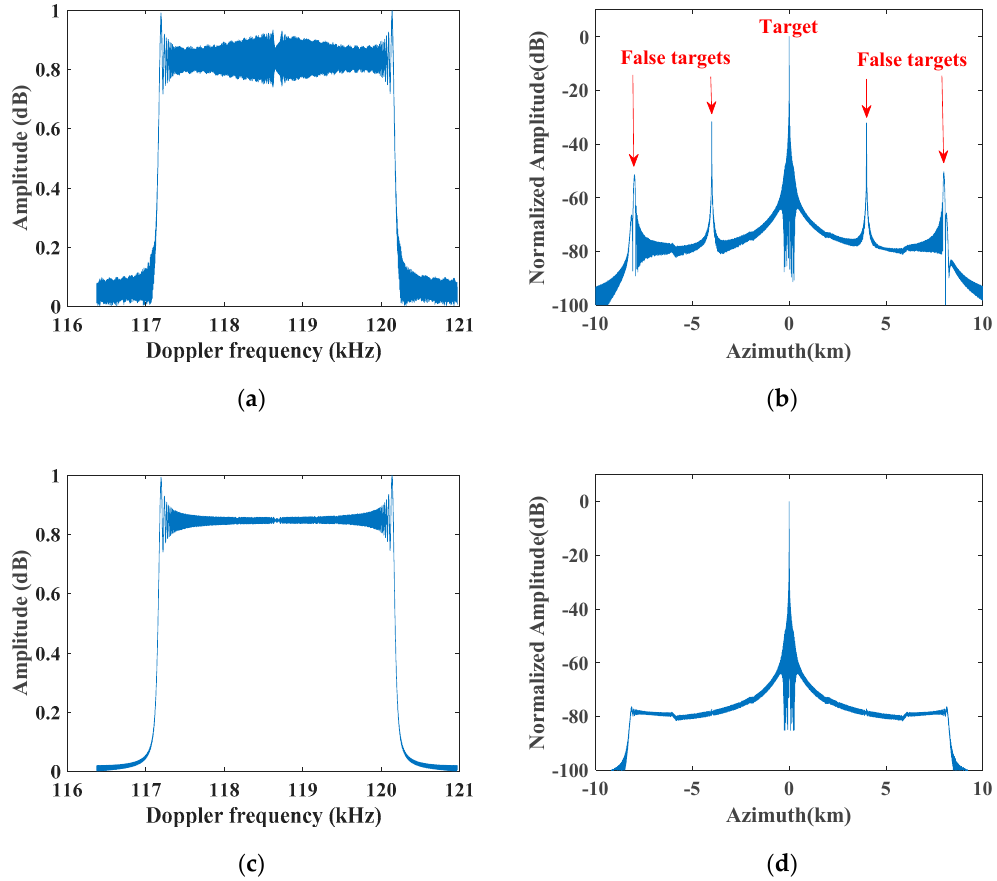
Figure 8. Azimuth multichannel reconstruction based on AHRE in a distributed DPCMAB SAR system. ( a ) Azimuth spectrum after conventional multichannel reconstruction; ( b ) azimuth compression result of ( a ); ( c ) azimuth spectrum after improved multichannel reconstruction; ( d ) azimuth compression result of ( c ).